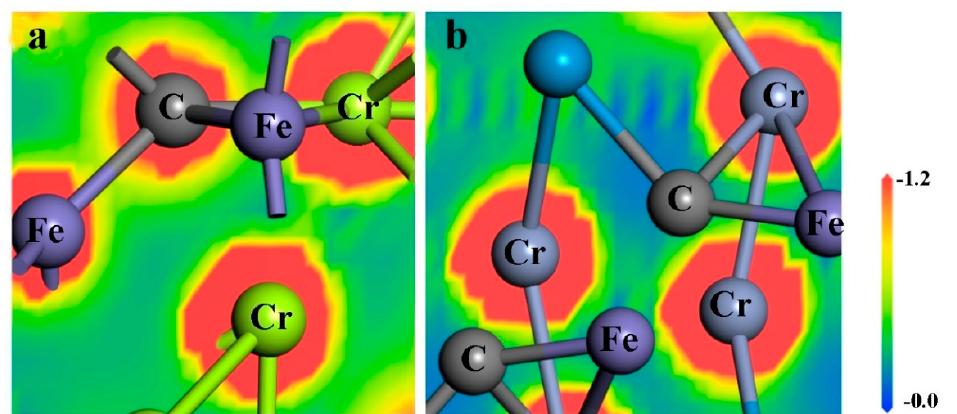
Figure 7. The valence electron density for (a) Fe 3 Cr 4 C 3 and (b) Fe 3 Cr 2 W 2 C 3 .